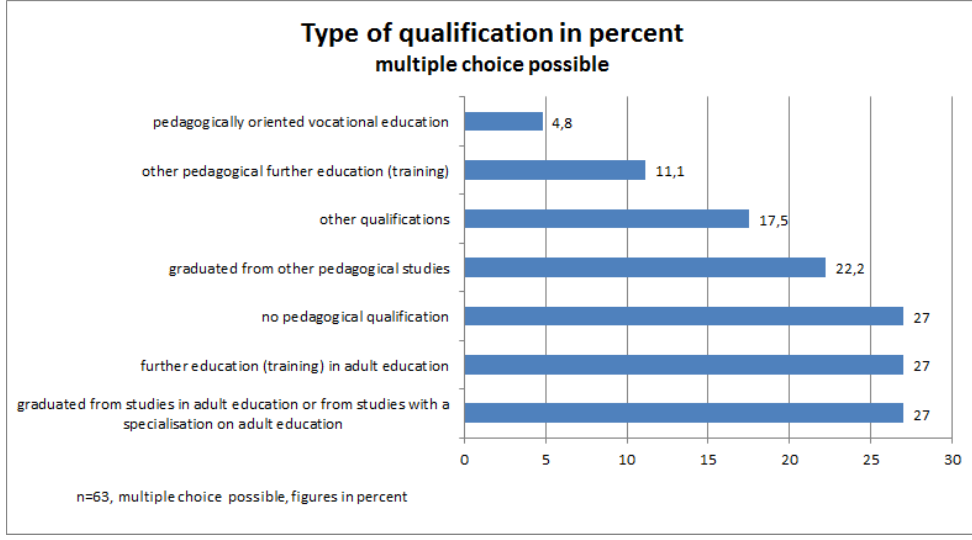
Figure 4. Type of qualification (n=63, figures in percent) (Source: own figure) Research Results of Management